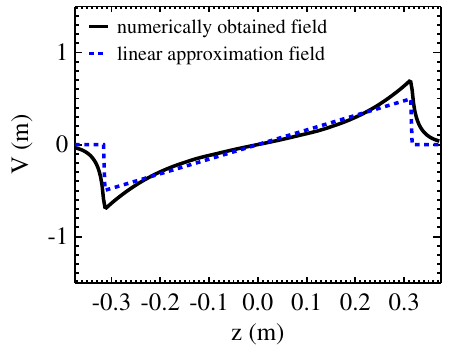
FIG. 1. The longitudinal electric field for a bunch with a =a ¼ 9 and a ¼ 3 : 5 cm . The parabolic line density with z m plot shows the numerically obtained field (solid curve) together with the linear approximation (dashed blue curve).